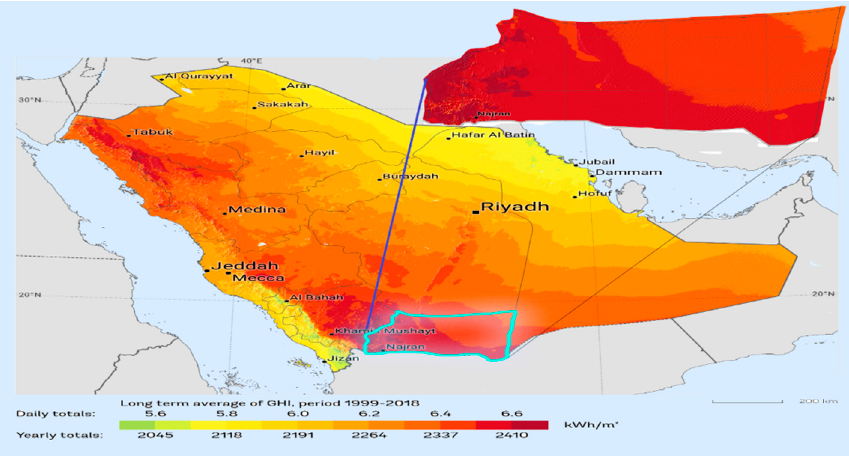
Figure 2. Geographical representation of Najran province for global solar radiations.